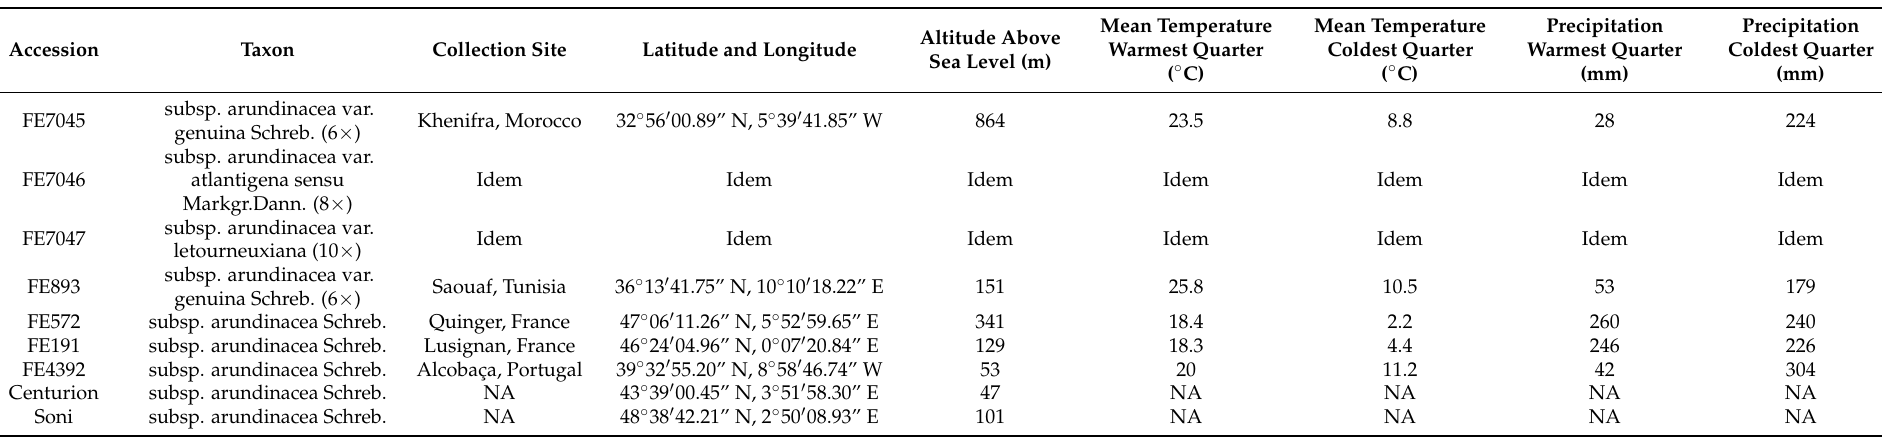
Table 1. Information of the accessions of Festuca arundinacea Schreb. used in this study (http://florilege.arcad-project.org/fr/collections/collection-especes- fourrageres-a-gazon, accessed 22 May